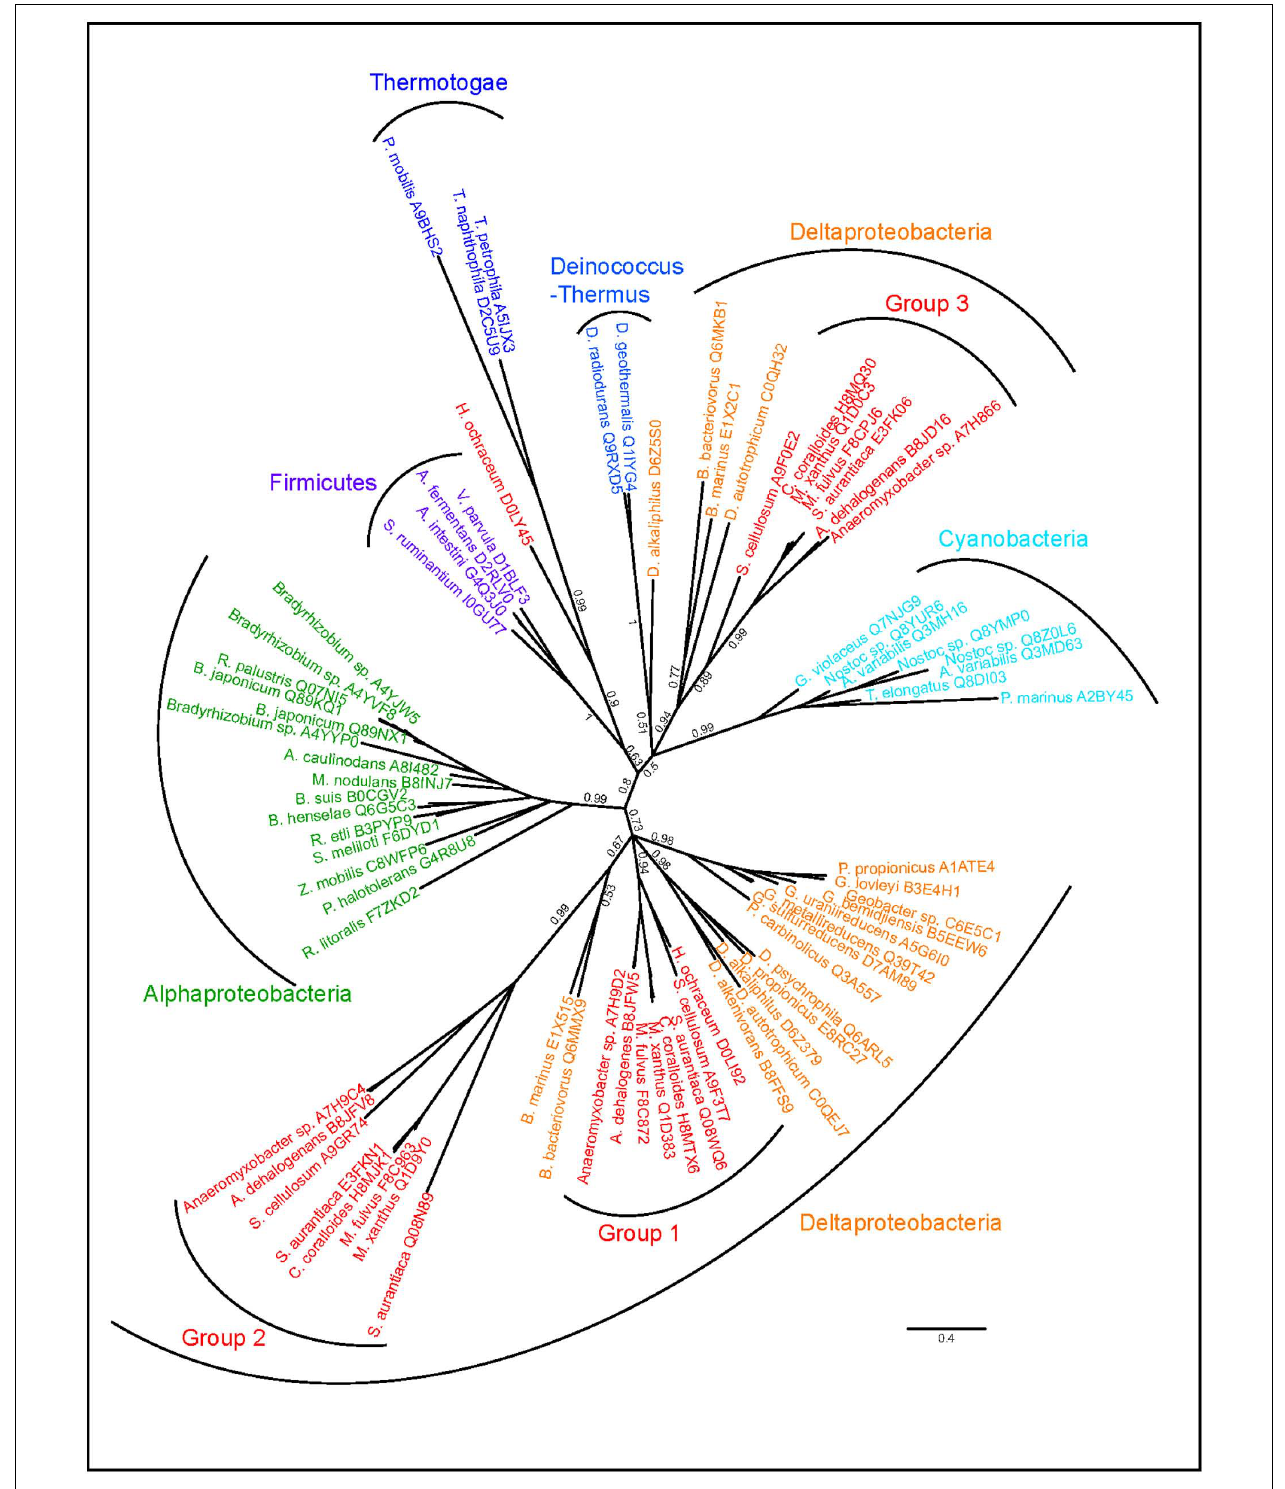
FIGURE 6 | Independent sets of BamA proteins in the Myxococcales . Phylogenetic tree of BamA sequences identified in Myxobacteria and their closest taxonomic relatives.Tree calculations were performed using